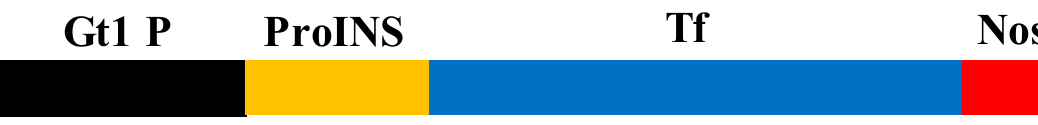
Figure 1. Diagram of the plasmid construct for the expression of proinsulin-transferrin fusion protein (ProINS-Tf). Gt1 P, glutelin promoter; ProINS, the codon-optimized proinsulin gene; Tf, the codon-optimized human transferrin gene; Nos, nopaline synthase terminator.